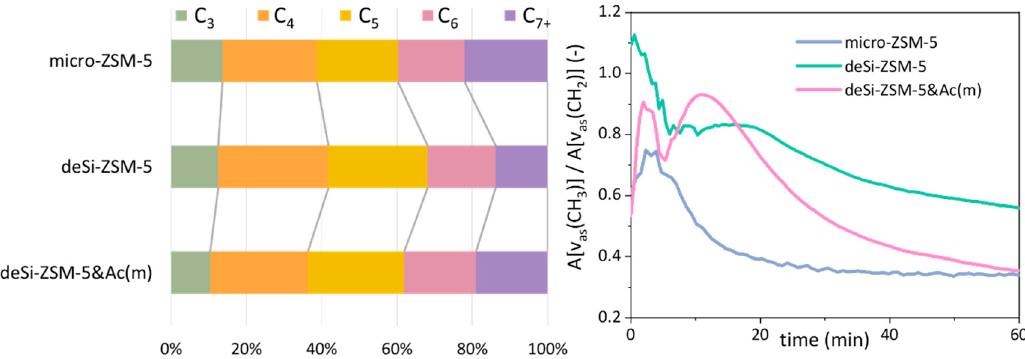
Figure 5. ( left ) Selectivity to C n groups of hydrocarbons in total amount of products formed upon cracking of LDPE; ( right ) CH 3 /CH 2 band intensity ratio derived from FT-IR operando studies as a function of time during LDPE cracking for microporous (micro), desilicated (deSi) and mildly acid-washed (Ac(m)) ZSM-5 zeolites.